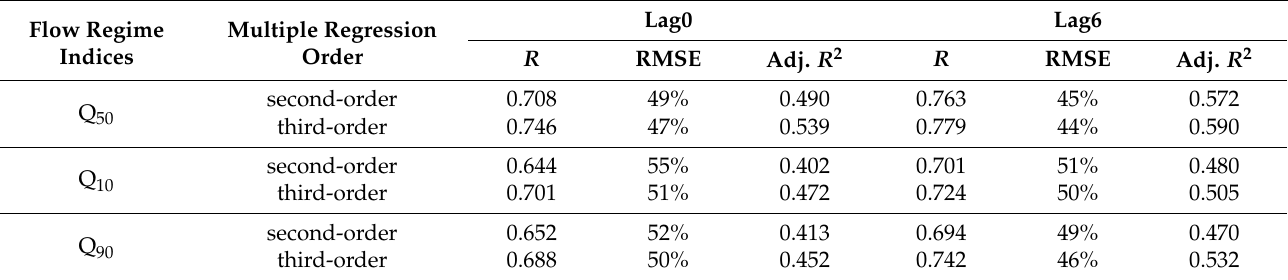
Figure 4. Comparison between the observed variables and the estimated flow regimes by multiple polynomial regression model with 6-month moving average dataset. There are two figures: ( a ) The scatterplots of the estimated versus observed values; ( b ) The time series of observed (Q 50 , Q 10 , Q 90 , SOI, and DMI) and estimated (Q 50 , Q 10 , and Q 90 ) values in 1994–2005 (left side of the separation line) and 2010–2018 (right-side of the separation line). Table 3. Multiple regression (MR) model evaluation for a 6-month moving average dataset in not-lagged (lag0) and 6-month lagged (lag6) MR. R is the Pearson correlation coefficient between the estimated and observed flow regime indices. RMSE is the root mean square error in percentage to the observed average. Adj. R 2 is the Adjusted R 2